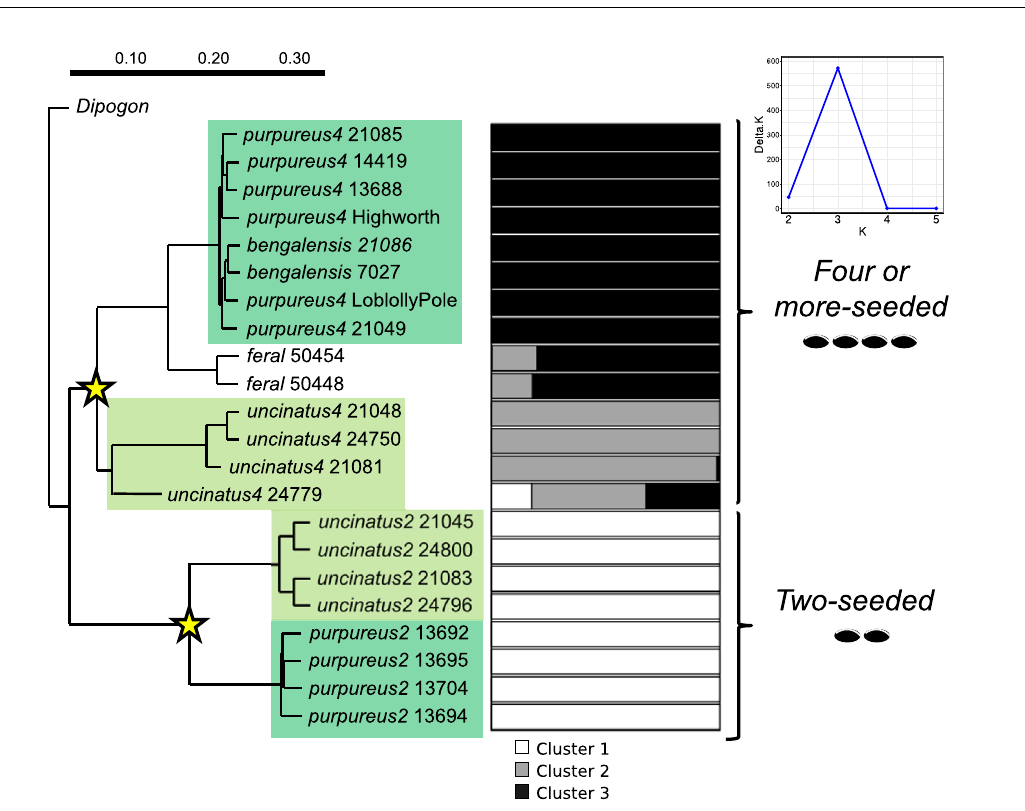
Fig. 3 | Trypsin inhibitor gene family in lablab. a Phylogeny of the trypsin inhi- bitor encoding genes in fi ve different legume species including lablab ; branch thickness corresponds to bootstrap values and increases with higher bootstrap; tree is rooted with the most divergent sequence from Arabidopsis; outer blue connections: tandemly duplicated genes, outer red connection: syntenic collinear genes. b Copy number of trypsin inhibitor genes in different plant species.